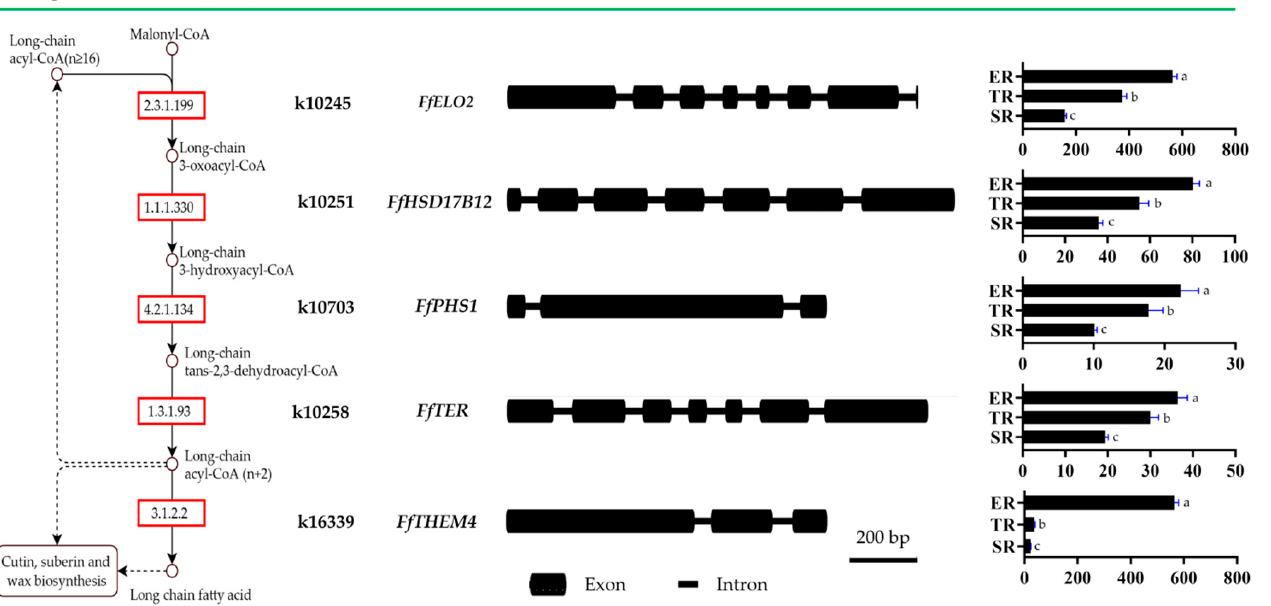
Figure 11. Expression of long-chain fatty acid synthesis of fatty acid elongation pathway (PATH: map00062, Module: M00415) genes in elongation region (ER), transition region (TR), and two stable regions (SR’ and SR). Letters over columns denote significant differences ( p < 0.05, n = 4, paired t test). The fatty acid composition of elongation and stable regions is shown in Figure 12. Short-chain (C8 to C12), long-chain (C14 to C20), and very-long-chain (C20 to C24) fatty